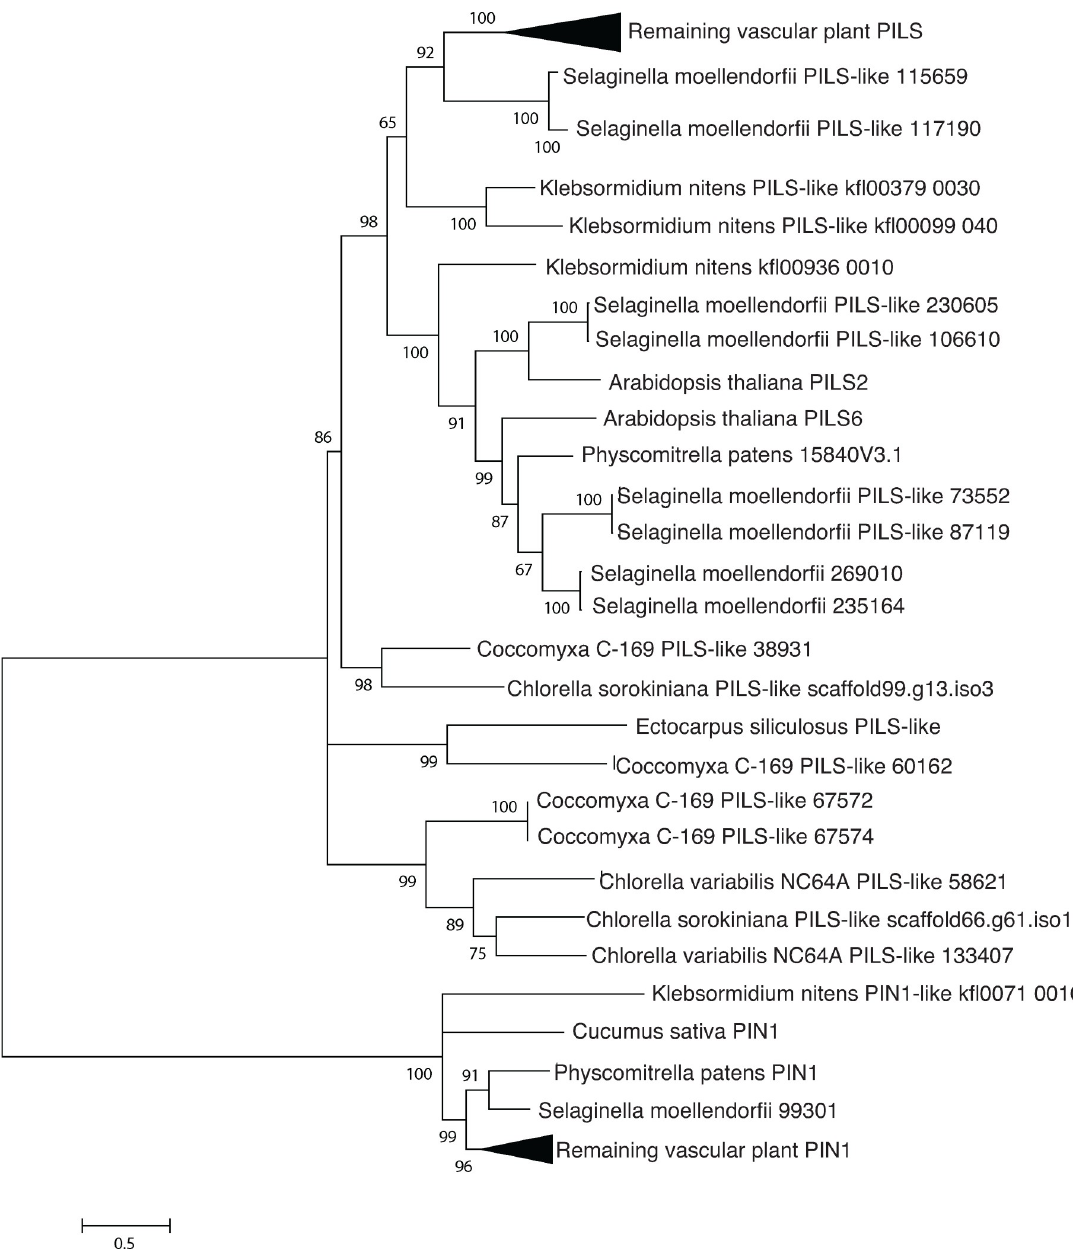
Fig 2. Phylogenetic analysis indicates sequence conservation of PILS. PILS (PIN-like) transporters, similar to but distinct from PIN proteins, mediate intracellular auxin transport. Putative orthologs and outgroups were identified by reciprocal BLAST searches, aligned with Clustal Omega and analyzed using the LG+I substitution model in MEGA